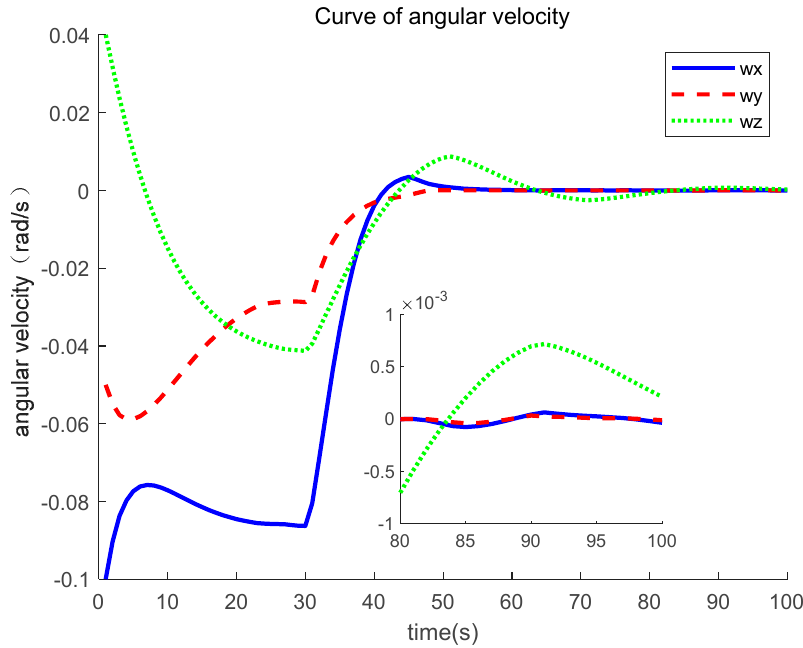
Figure 9. Curve of angular velocity under the controller proposed in this paper with actuator failure.